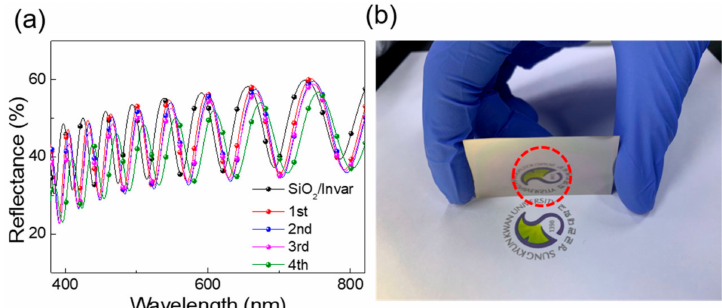
Figure 4. ( a ) Reflectance of brush-painted Ag NWs network coated on SiO2 / invar metal substrate with increasing number of brush painting. ( b ) SKKU logo reflected on the surface of Ag NWs / SiO 2 / invar metal